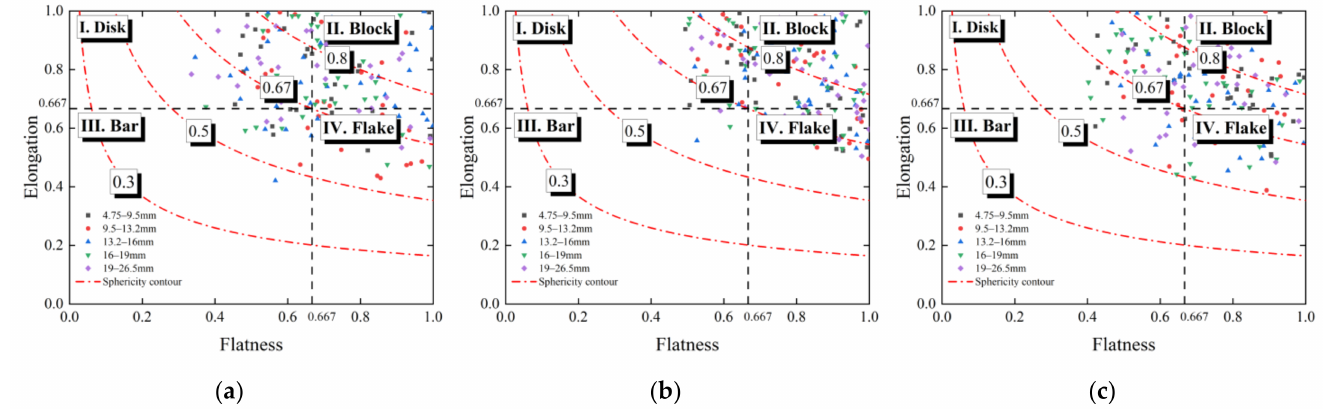
Figure 3. The shape classification results of three different types of aggregate particles recycled from